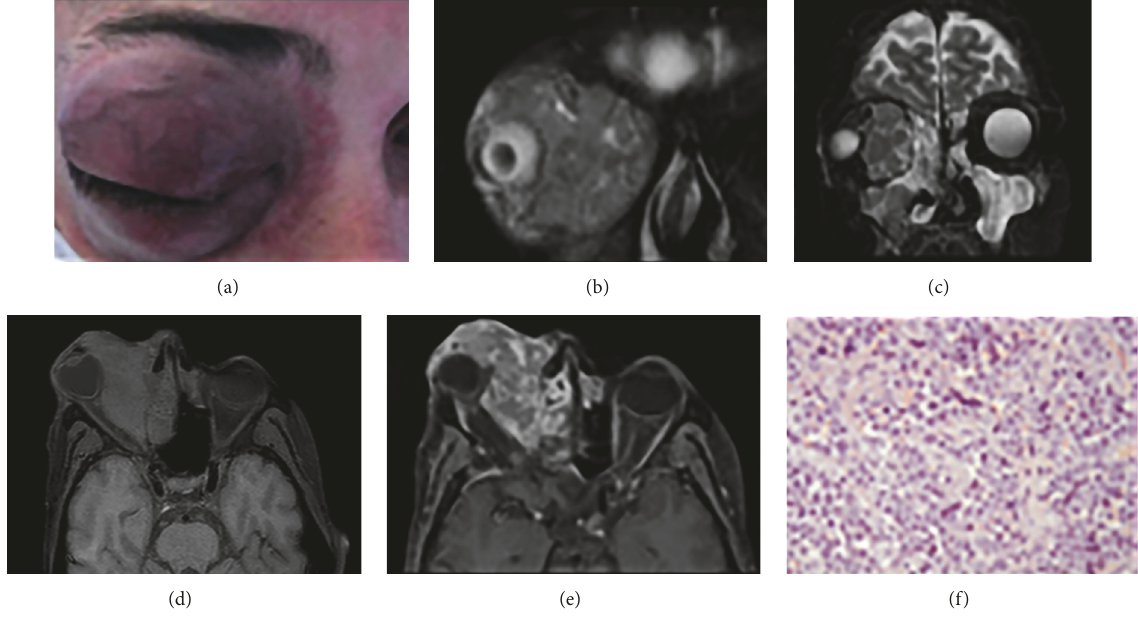
Figure 1: At clinical examination the patient shows proptosis, downward displacement of eye, periorbital swelling, and redness (a). MRI fat-suppressed coronal T2-weighted (b, c) and axial T1-weighted images (d) show an inhomogeneous hypointense mass located in the lateral aspect of the right orbit that extends to the nose and ethmoid sinus with intense and heterogeneous contrast enhancement (e). H&E stain of the tumor shows a monomorphic proliferation of plasmablastic cells